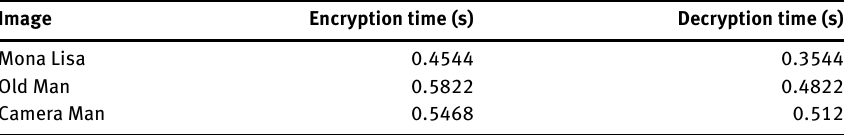
Table 4: Encryption and Decryption